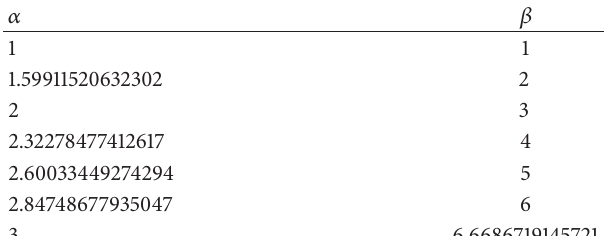
Table 2: Boundary line reference points.